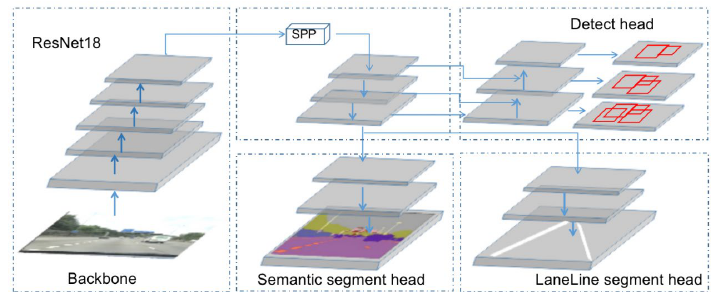
Figure 2. The architecture of OneNet.